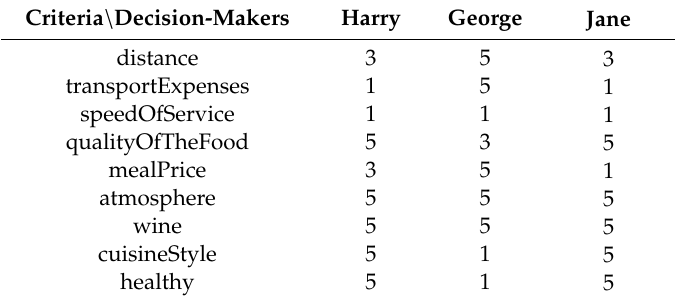
Table 6. Criteria predicted importance to each decision-maker. Criteria \ Decision-Makers Harry